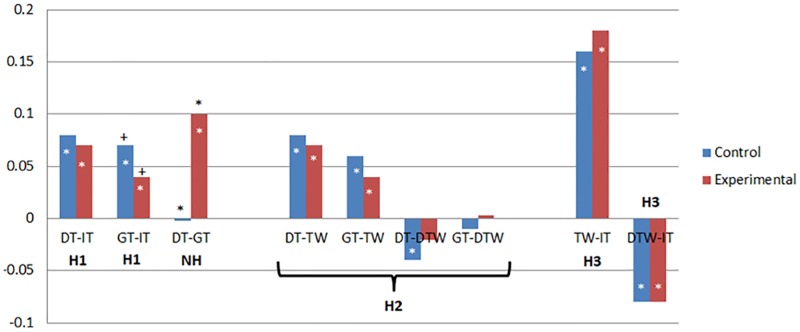
Covariances based on Multivariate Multilevel Model (MMLM) analyses.Notes. +p< .01, *p < .05; two-tailed, black outside bars = differences in covariances, white within bars = individual covariances. This figure is a graphical representation of the covariances listed in Tables 5, 6, 7 and 8. H1, H2, H3 indicate comparisons relevant to hypotheses 1, 2, and 3 respectively. H1 and H2 were that experimental would be < control. H3 was that experimental and control covariances would be different. NH indicates a comparison not hypothesized. DT = dispositional trust, GT = governmental trust, IT = institutional trust, TW = trustworthiness perceptions, DTW = distrustworthiness perceptions.